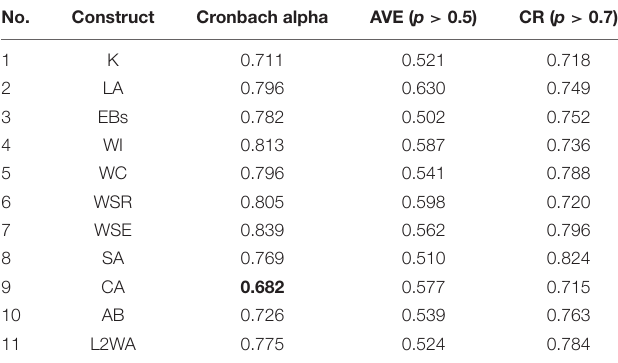
TABLE 8 | Composite reliability analysis for constructs.